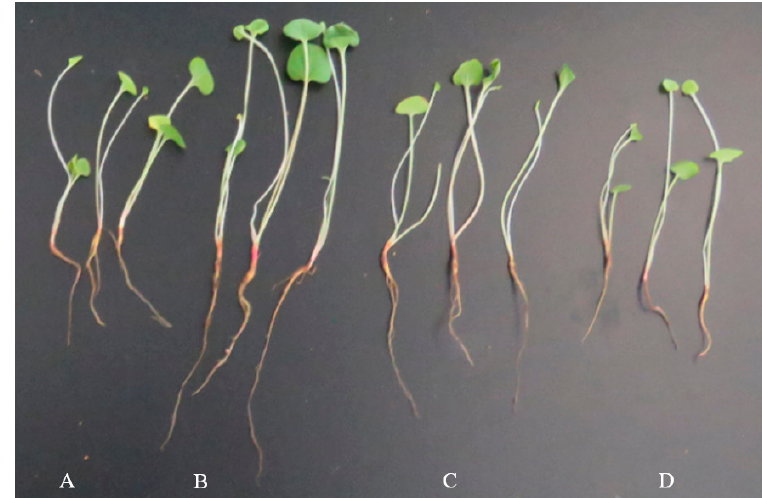
Figure 2. Effects of different concentration conidial suspensions of HT-1 strain on the growth of seedlings. Note: ( A ), seedlings treated with HT-1 strain at spore concentration of 10 6 spores/mL; ( B ), seedlings treated with the HT-1 strain at spore concentration of 10 7 spores/mL; ( C ), seedlings treated with HT-1 strain at spore concentration of 10 8 spores/mL; ( D ), CK (seedlings treated with distilled water).